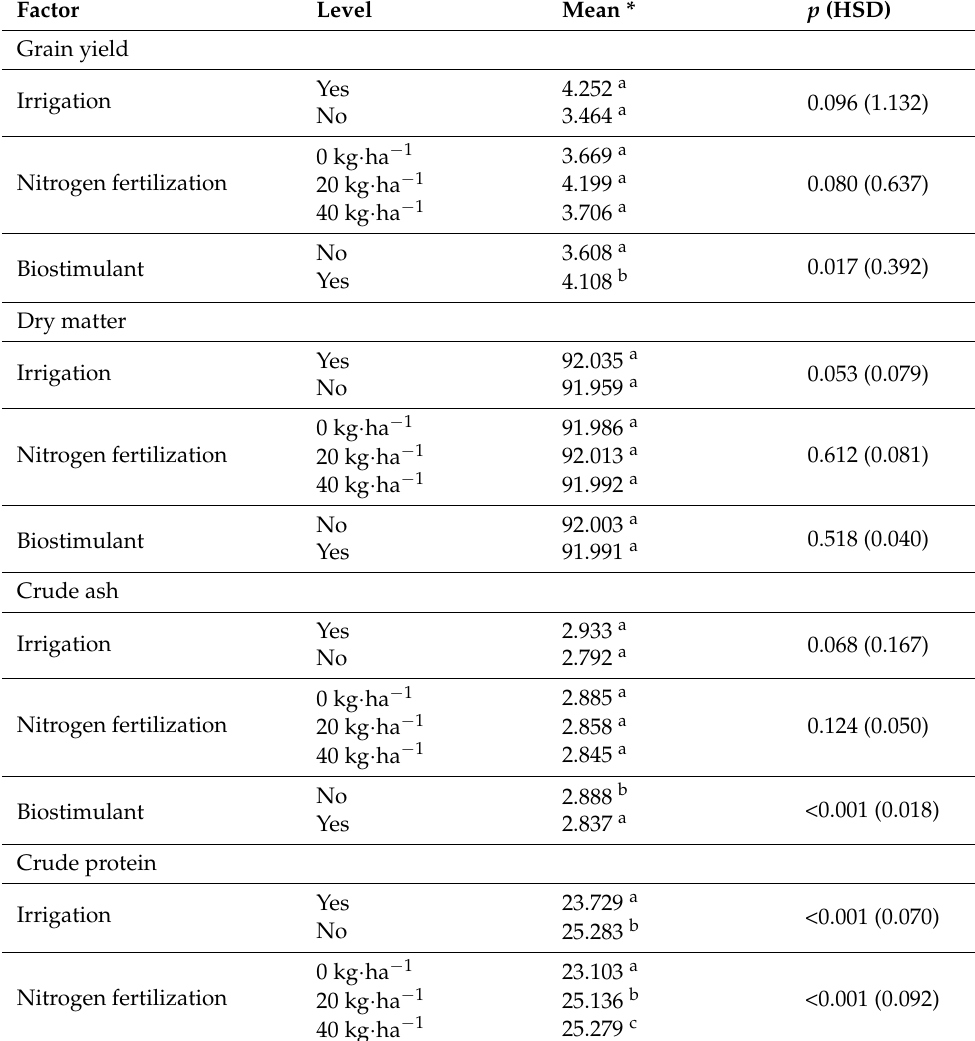
Table 1. Yield (Mg · ha − 1 ), proximate composition (%) and metabolizable energy (MJ · (1000 g) − 1 ) of the evaluated pea